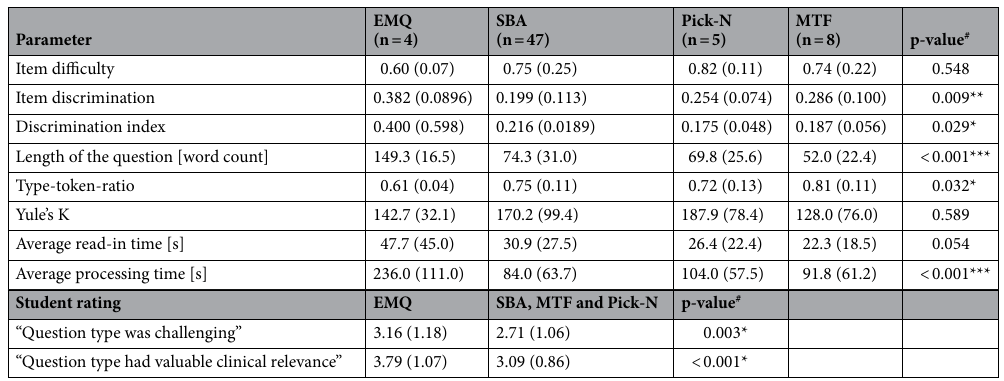
Table 2. Item characteristics of the different MCQ item types and results of the online survey. Data are portrayed as mean (SD). *p < 0.05; **p < 0.01; ***p < 0.001. # As calculated by one-way ANOVA or Welch- ANOVA as